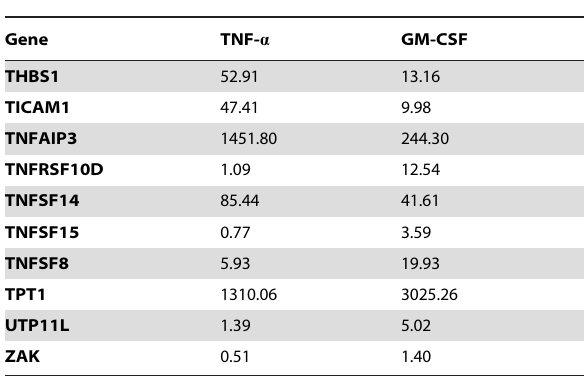
Table 3. The 58 apoptosis-related genes which had significantly different expression levels in TNF- a and GM-CSF treated neutrophils (FDR adjusted q-value #